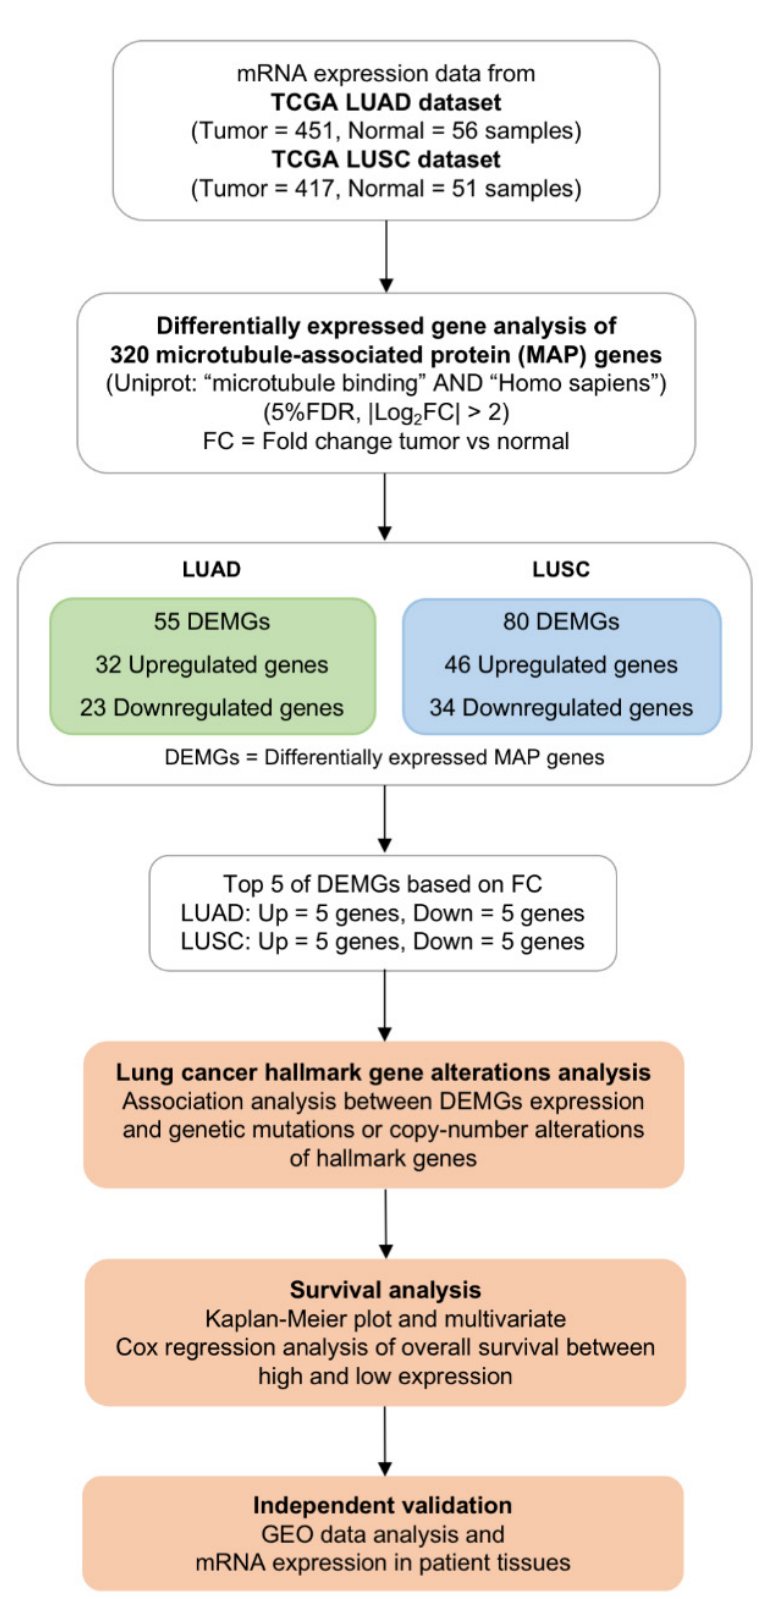
Figure 1. Schematic workflow for screening microtubule-associated protein (MAP)-encoding gene bi- omarkers. Table 1. Clinical characteristics of the Cancer Genome Atlas dataset.